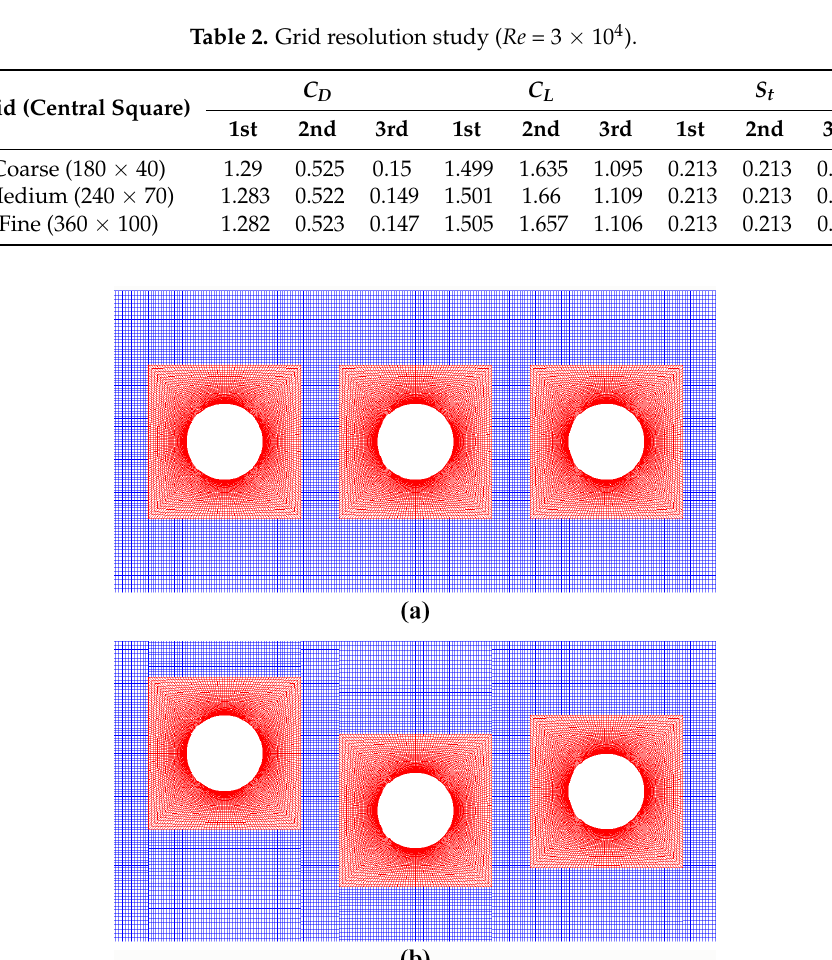
Figure 3. Topological change of dynamic mesh. ( a ) original mesh, ( b ) cylinders in FIV Table 2. Grid resolution study ( Re = 3 × 10 4 ).